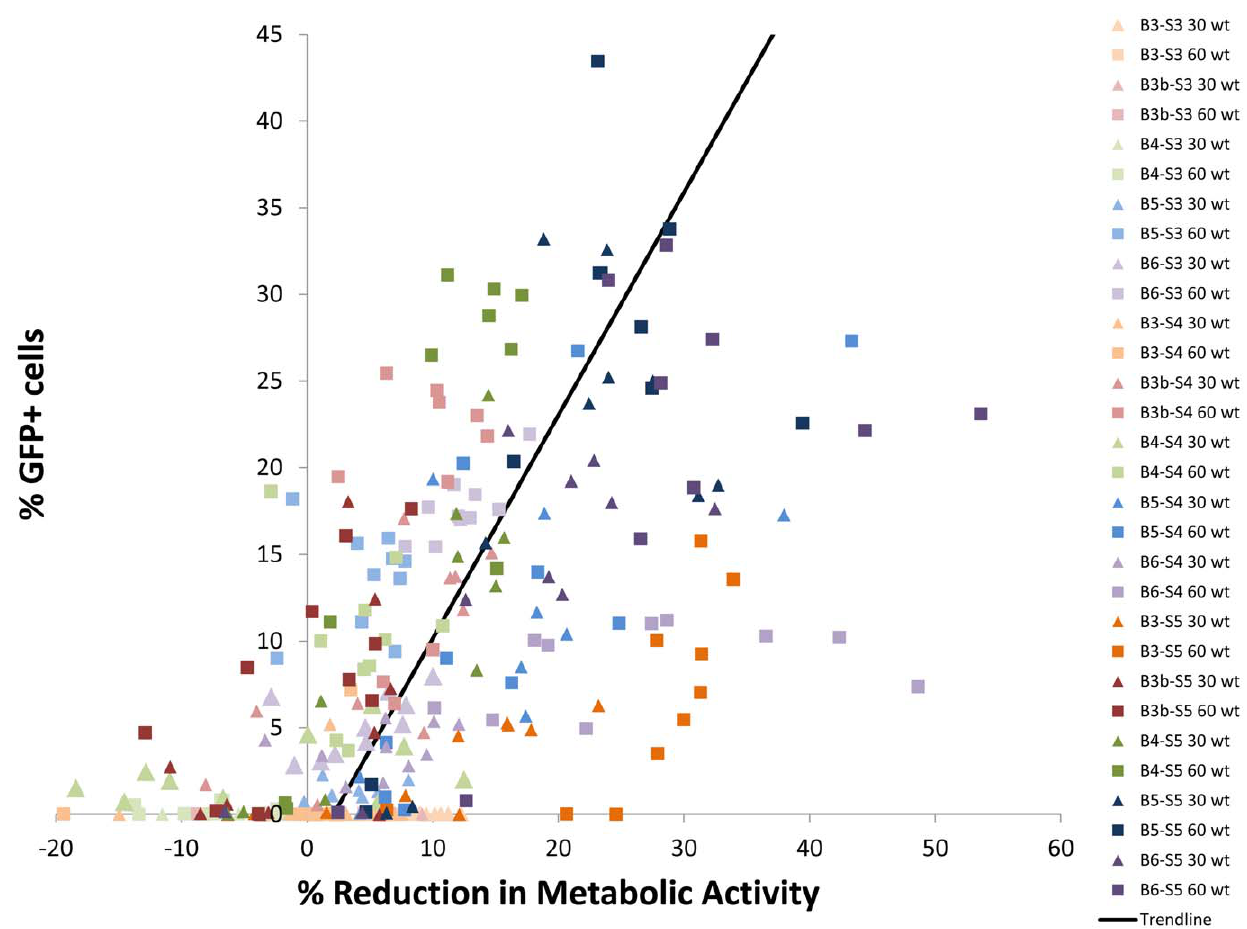
Figure 7. Comparison of transfection efficacy to reduction in metabolic activity of the polymers in the polymer library. There is an overall trend of increasing cytotoxicity with increasing transfection efficiency (the best-fit line represents a 0.77% decrease in cell metabolic activity with every 1% increase in transfection efficiency of the formulation) but the trend only explains a portion of the results (R 2 =0.37). A number of polymer formulations exhibited high transfection efficiencies and low concomitant cytotoxicities.